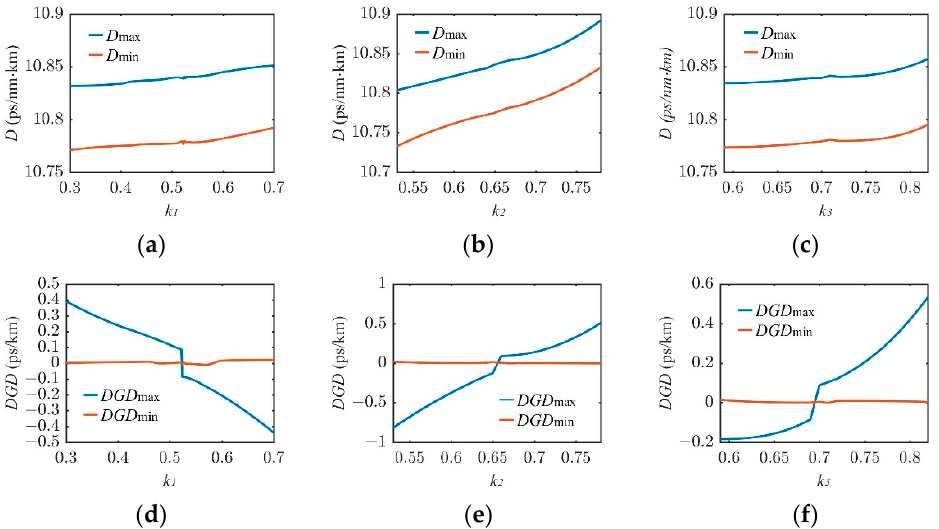
Figure 9. ( a ) Change in D with t ; ( b ) Change in DGD with t . Table 2. Parameter settings when reaching the minimum of the maximum dispersion coefficient and differential group delay.